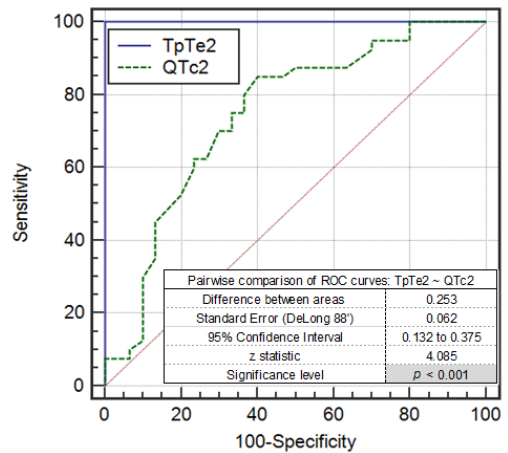
Figure 7. The pairwise comparison of ROC curves TpTe2~QTc2 [ms] in the syncopal group and control group in the upright phase during the HUTT—Phase 2